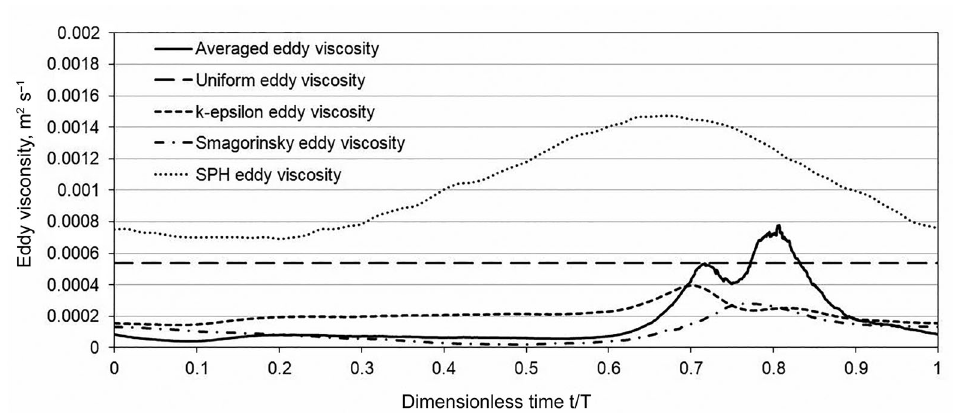
Fig. 6. Eddy viscosity estimates from different approximations: theoretical (averaged eddy viscosity in Fig. 5), empirical (uniform, k – ε and Smagorinsky eddy viscosity) and numerical (SPH eddy viscosity)